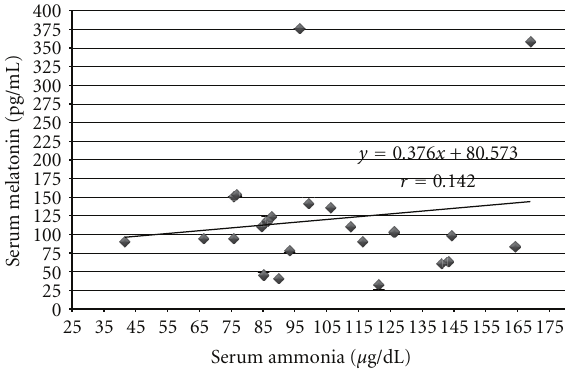
Figure 4: Correlation between ammonia and melatonin serum levels in cirrhotic patients with 3rd degree of hepatic encephalopa- thy (group HE 3 ) according to West-Haven Score; y : regression equation, r : correlation coe ffi cient, statistically insignificant.